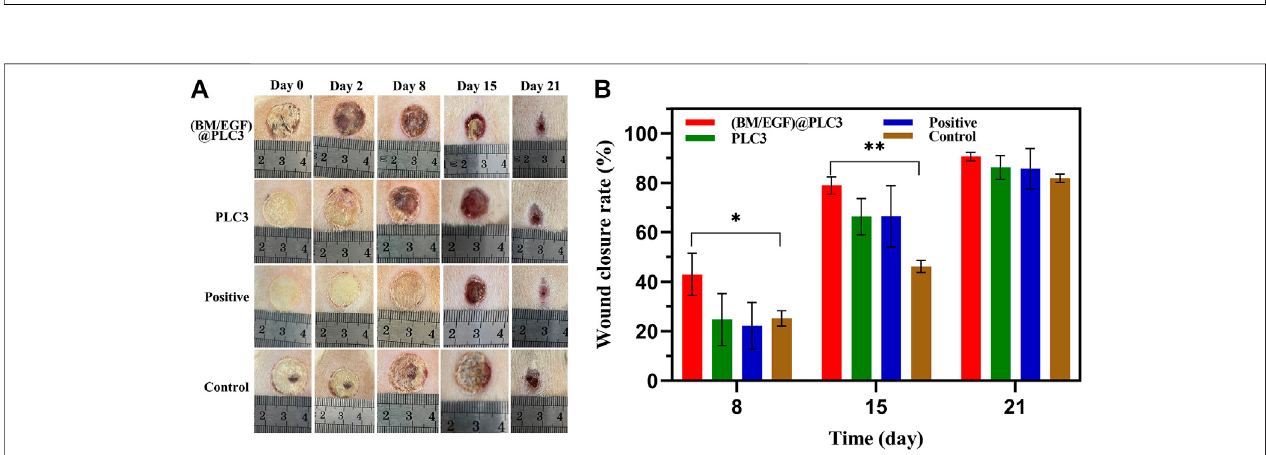
FIGURE6| Invivo treatmentoftheburningratmodel. (A) Assessmentoftheeffectoftreatmentondays0,2,8,15,and21. (B) Woundclosureratesondays8,15, and 21 before treatment. With the data shown as means ± SD ( n (cid:1) 3, * p < 0.05, ** p < 0.01).